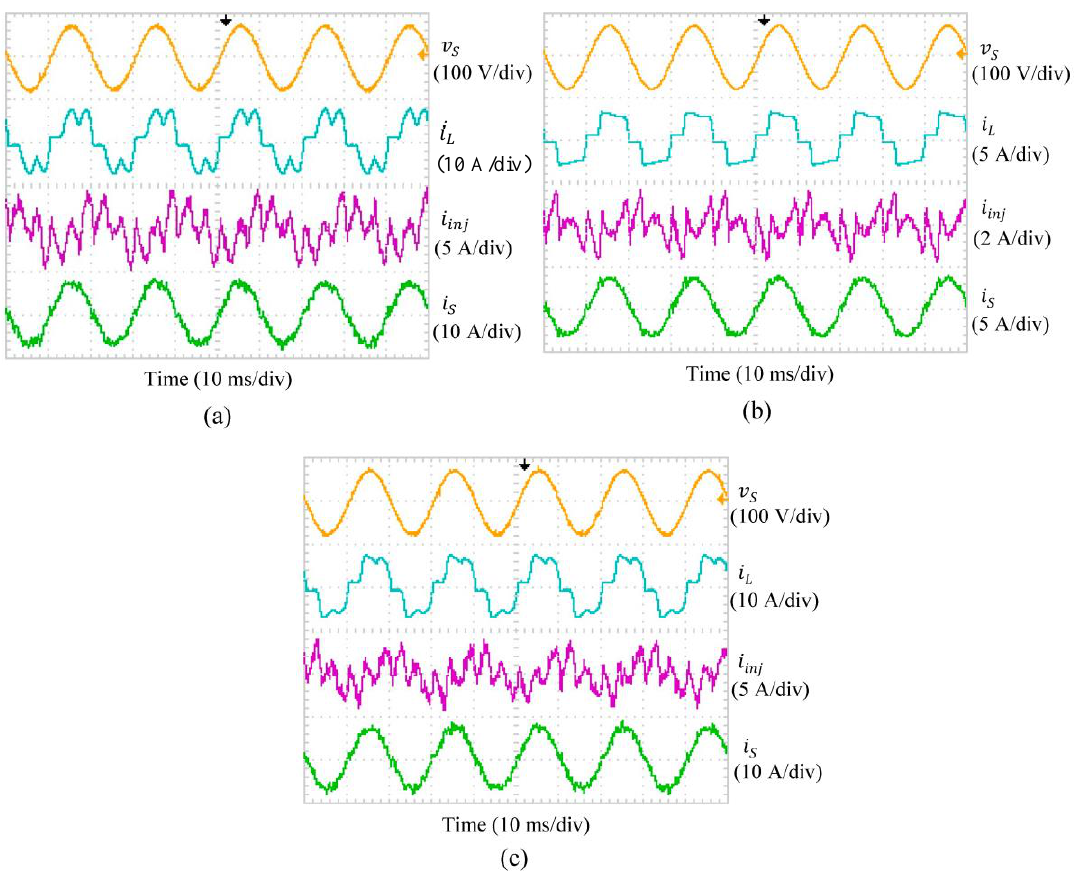
Figure 13. Experimental results (Phase A) of SAPF utilizing the proposed algorithm with IED control which include source voltage 𝑣 𝑆 , load current 𝑖 𝐿 , injection current 𝑖 𝑖𝑛𝑗 and source current 𝑖 𝑆 for ( a ) capacitive; ( b ) inductive and ( c ) resistive loads.